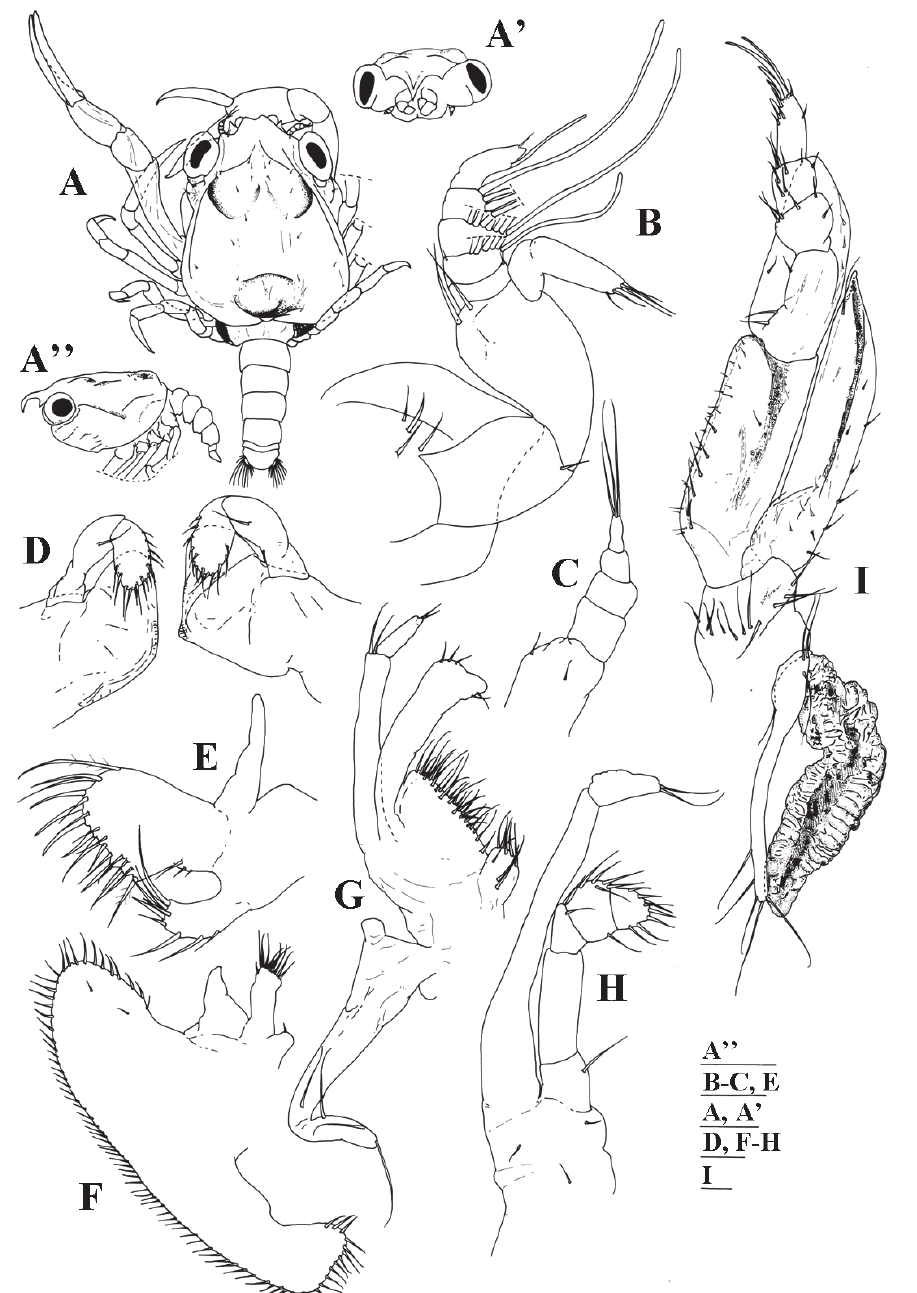
Fig . 5. – Ilia nucleus . Megalopa: a, general aspect, dorsal view; a’, detail of frontal view of the rostrum; a’’, general aspect, lateral view; B, antennule; C, antenna; d, mandibles; e, maxillule; F, maxilla; g, first maxilliped; H, second maxilliped; i, third maxilliped. scale bars: 1.0 mm (a’’); 0.1 mm